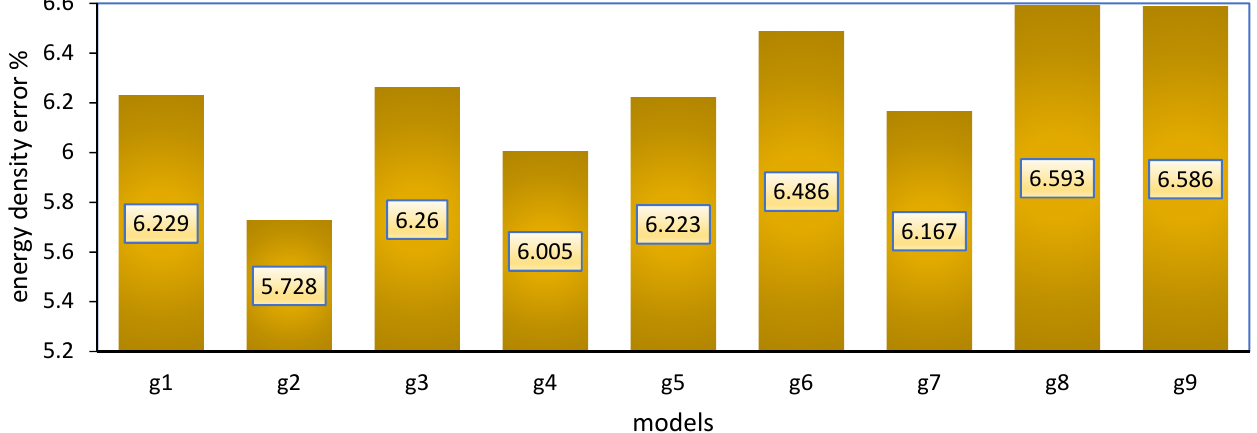
Figure 9. Energy density error of the nine models for Zafarana site.